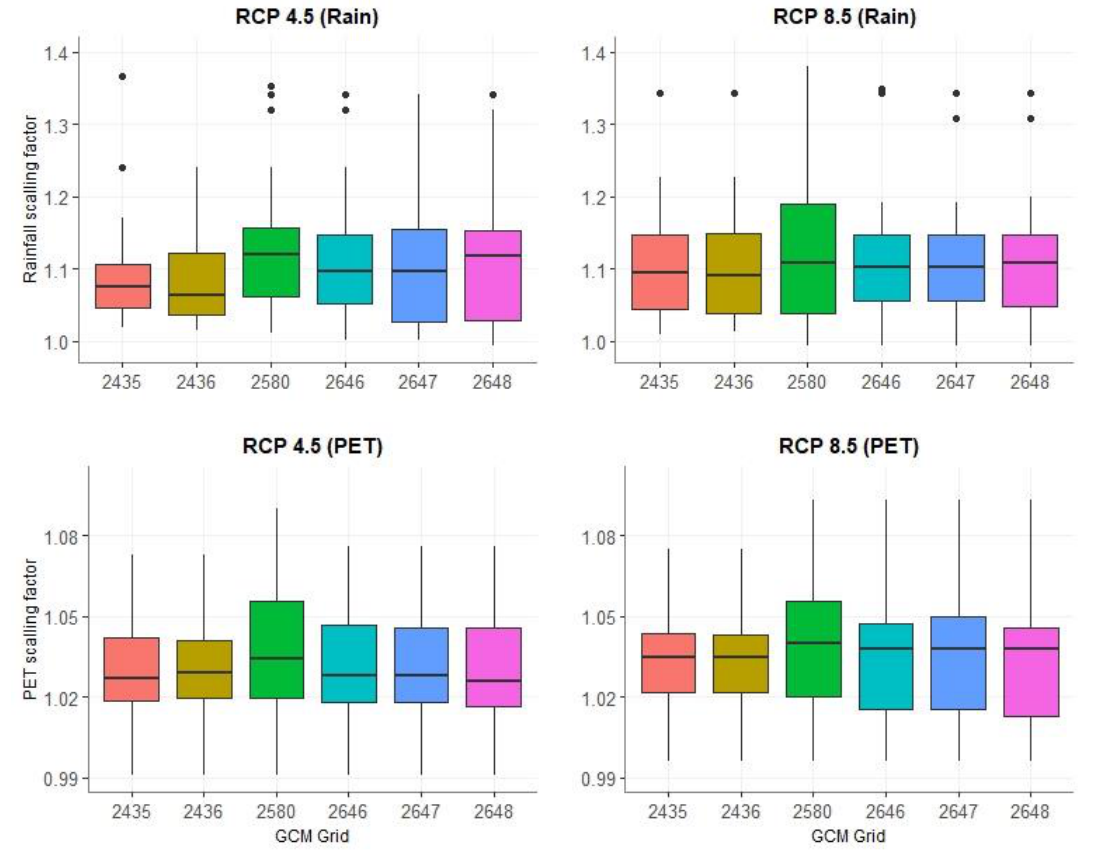
Figure 7. Quantile plots of scaling factors for the six GCM grids in the northwest region of Bangladesh.